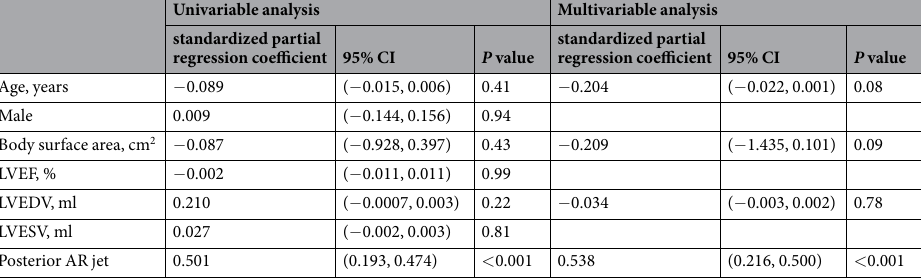
Table 4. Univariable and multivariable analyses of anterior mitral leaflet area/posterior mitral leaflet area ratio CI, confidence interval; LVEF, left ventricular ejection fraction; LVEDV, left ventricular end-diastolic volume; LVESV, left ventricular end-systolic volume; AR, aortic regurgitation. Data are presented from the single and multiple regression analyses.